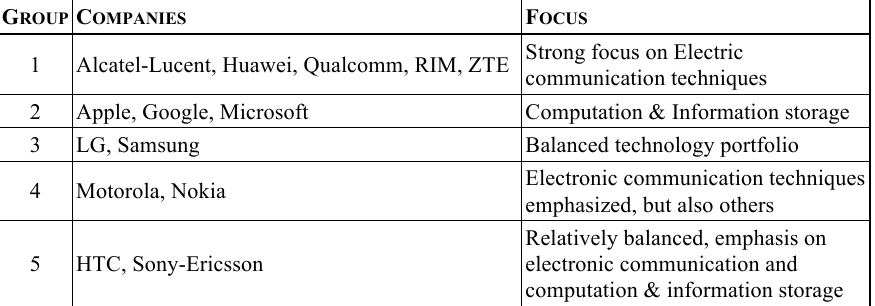
Fig. 2 . Technology strategy clusters Table 3 . Technology strategy cluster